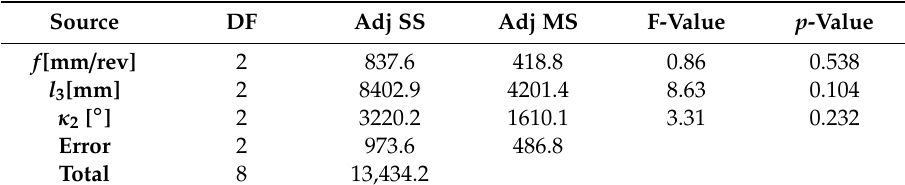
Table 6. Analysis of ANOVA variance for burr height h .